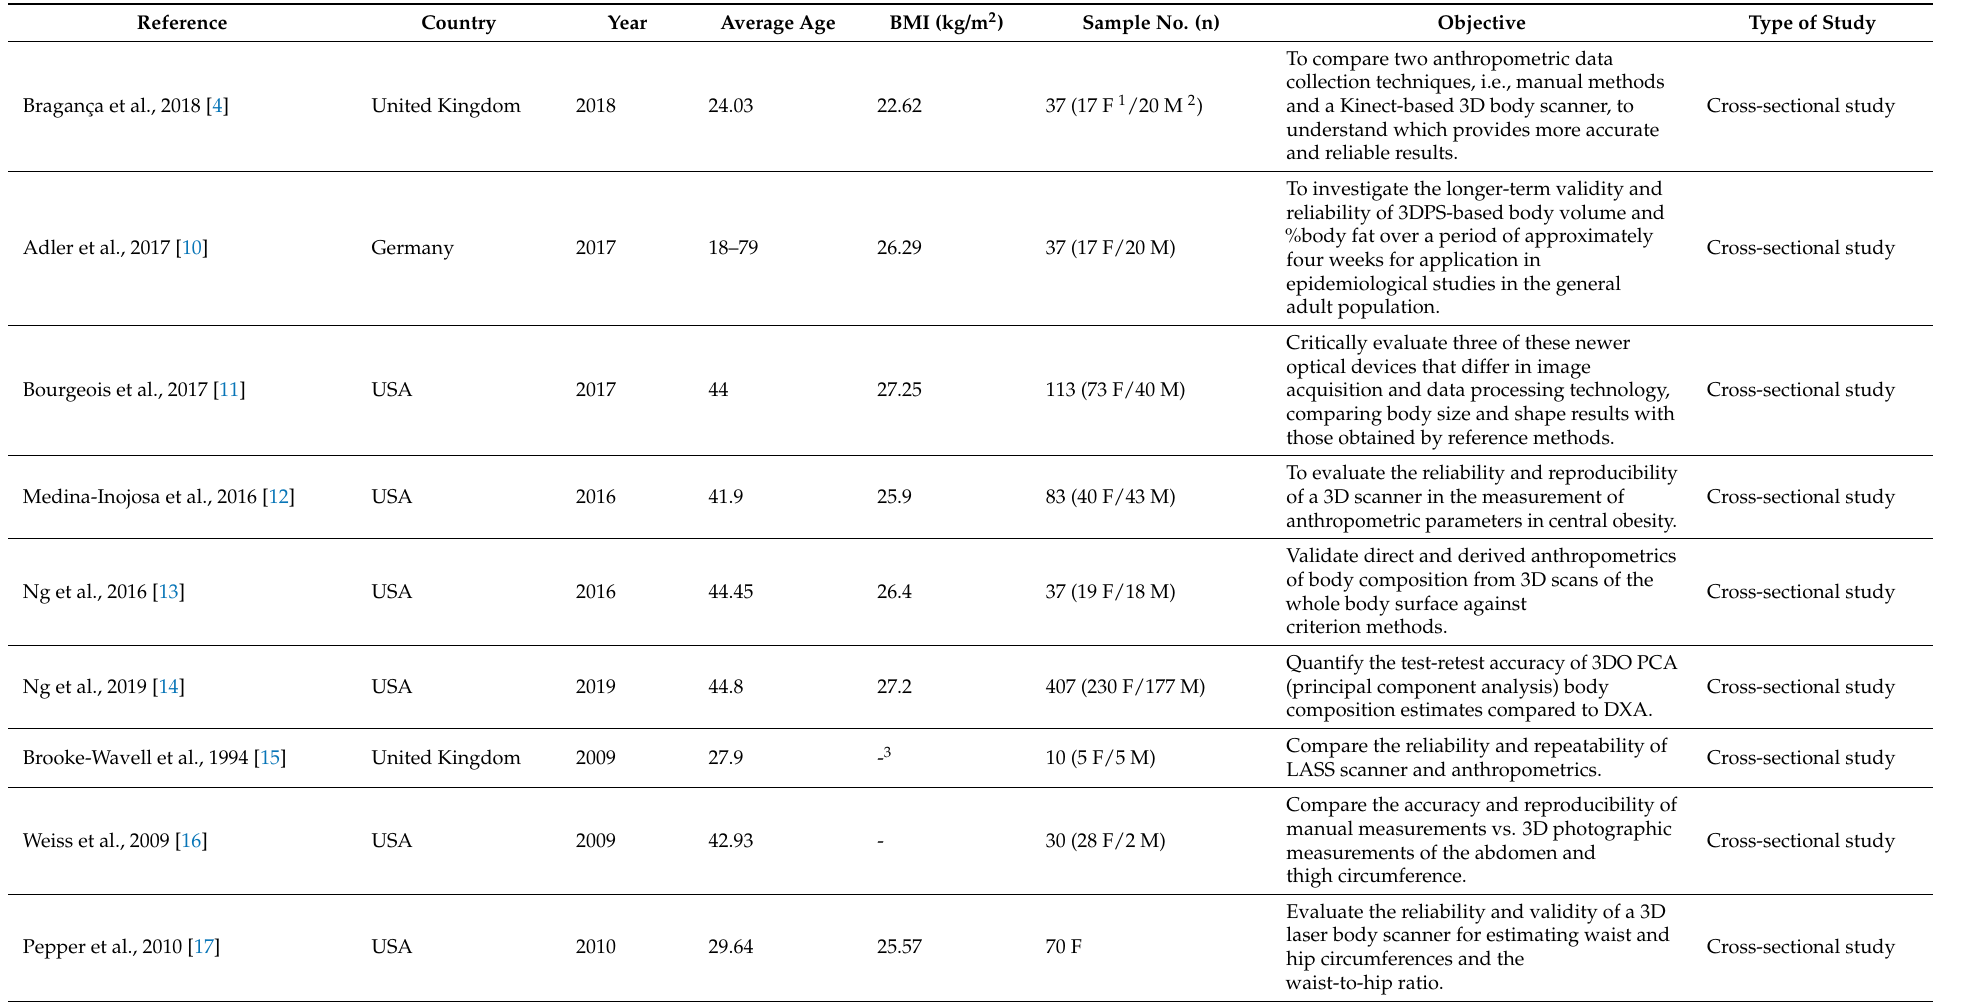
Table 4. Description of the studies included in the